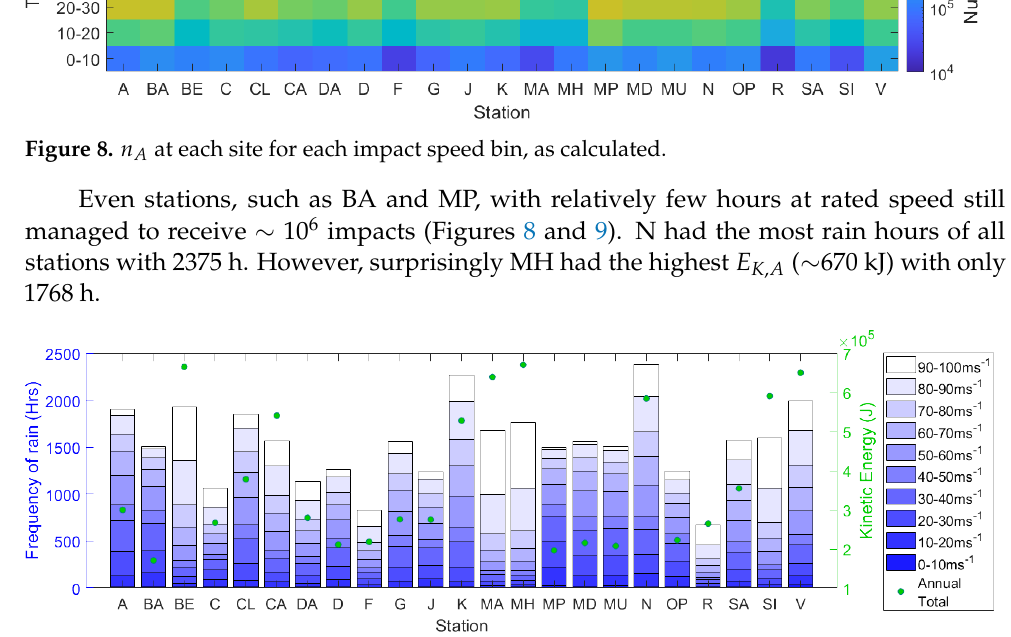
Using the model, Galway wind park would have an E K , A of ∼ 585 kJ. By extrapolating the models, the three wind parks with the highest E K , A would be Clydaghroe ( ∼ 673 kJ), Kilgarven ( ∼ 662 kJ) and Coomacheo ( ∼ 658